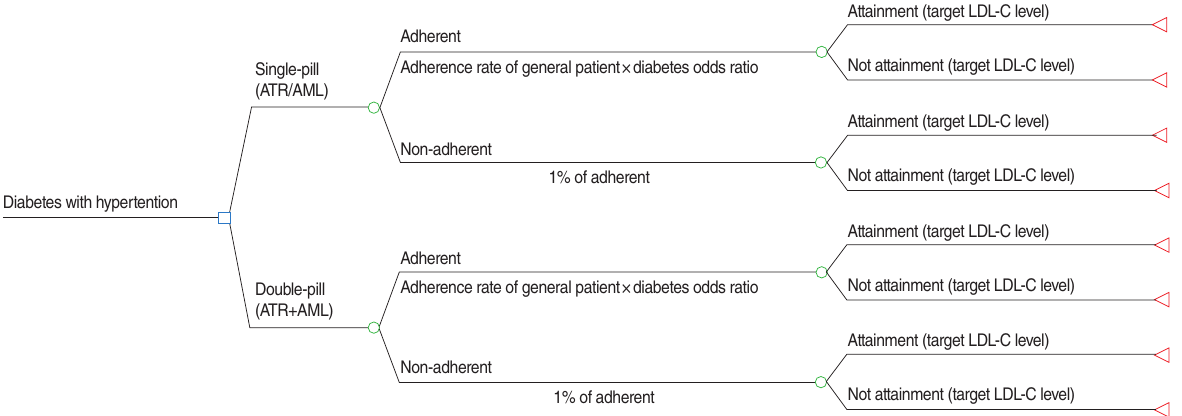
Figure 1. Cost-effectiveness analysis model. ATR, atorvastatin; AML, amlodipine; LDL-C, low density lipoprotein cholesterol. Table 1. Source of data in the model from the systematic review Author